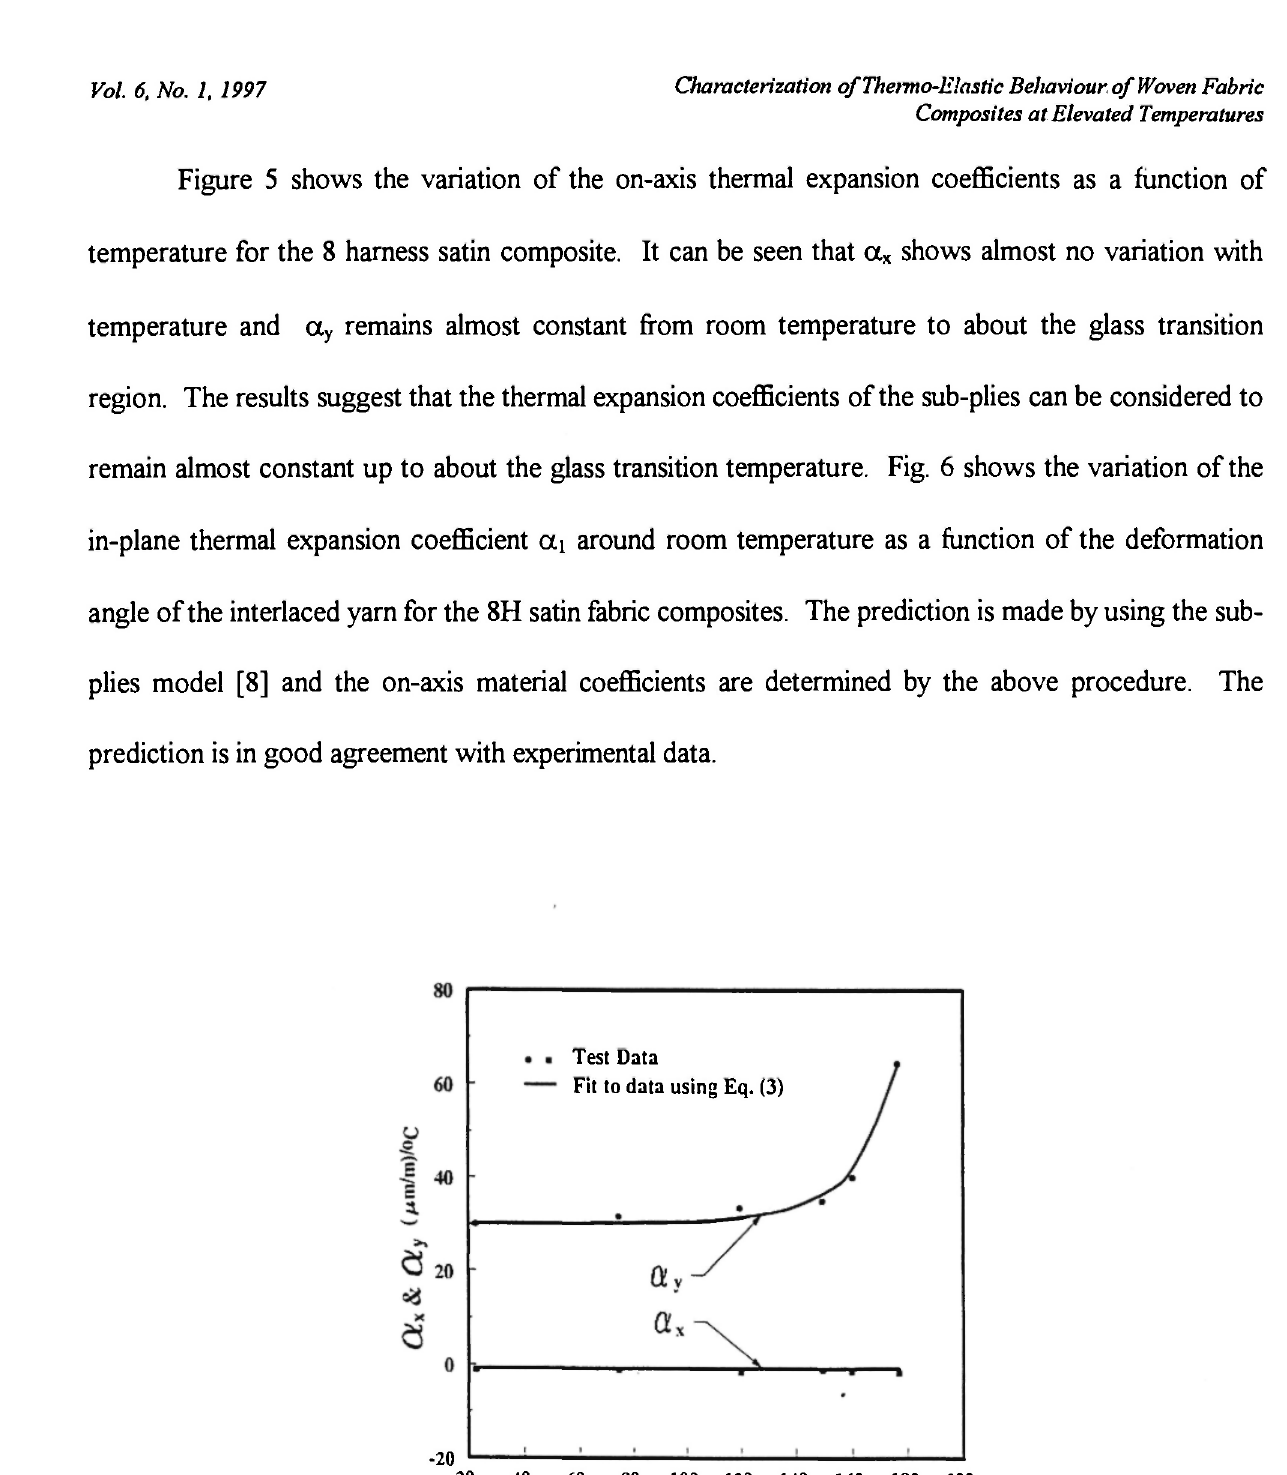
Figure 5: Variation of the normalized equivalent on-axis thermal expansion coefficients as a function of temperature for the 8-harness satin